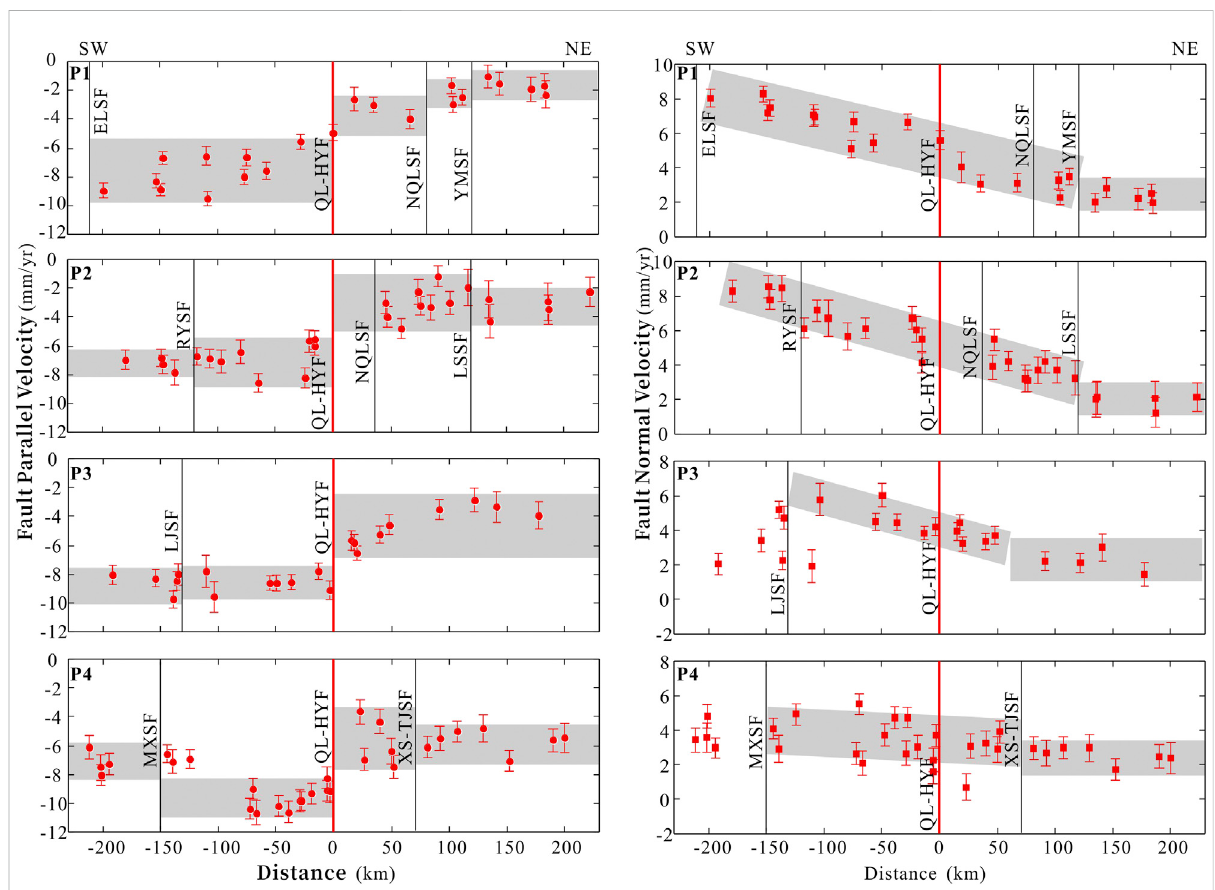
FIGURE 3 GPS horizontal velocity pro fi le across the faults. Locations of each pro fi le are shown in Figure 2. Red bars denote ranges of velocity measurements. Red line marks the Qilian – Haiyuan fault, while the black line marks other fault. Charts on the left are parallel velocities of the fault along the four pro fi les across the fault. Charts on the right are normal velocities. The middle value in the gray rectangle is used to determine slip rate of